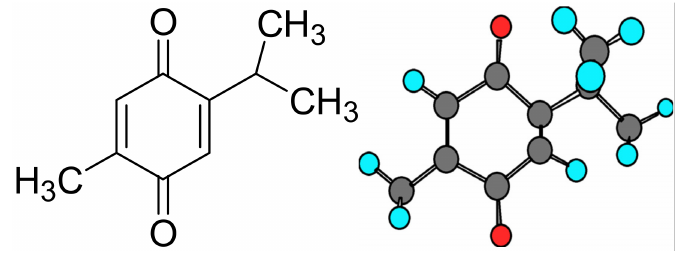
Figure 1. 2D and 3D structure of thymoquinone, C 10 H 12 O